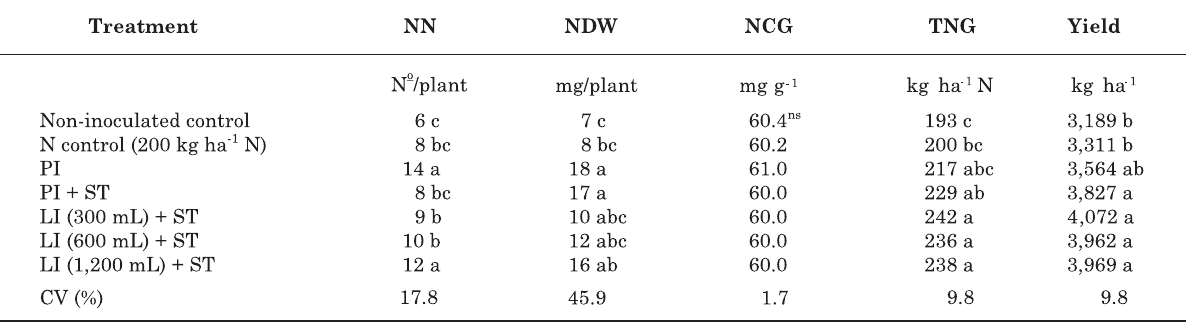
Table 3. Nodule number (NN) and dry weight (NDW) at the V4 stage, N grain content (NGC), total N grain content (TNG), and grain yield at the harvest of soybean inoculated with peat (PI) or liquid (LI) inoculant, with or without seed treatment (ST) with fungicides and micronutrients (1) . Experiment conducted in Londrina, Paraná, in the 2001/2002 growing season, in a soil with pre-established soybean/ Bradyrhizobium